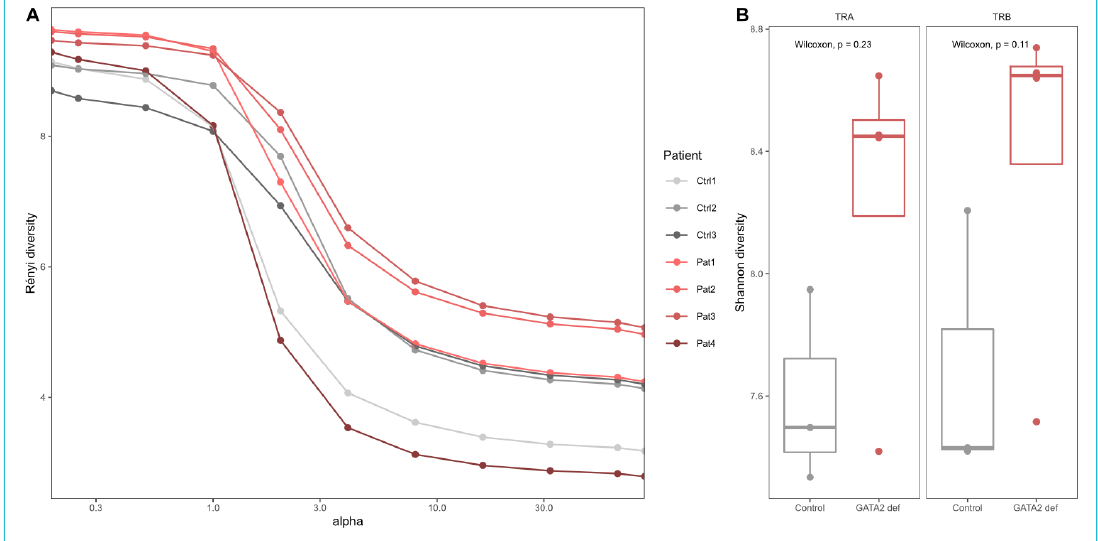
Figure 2: Repertoire diversity analysis. Diversity indices calculated on the clonal relative frequencies of sequences in the subsampled dataset. (A) Rényi diversity profiles where a = 0 reflects clonal richness, a = 1 corresponds to the Shannon index and a = 2 represents the Simpson in- dex. (B) Shannon diversity index for both clonal chains